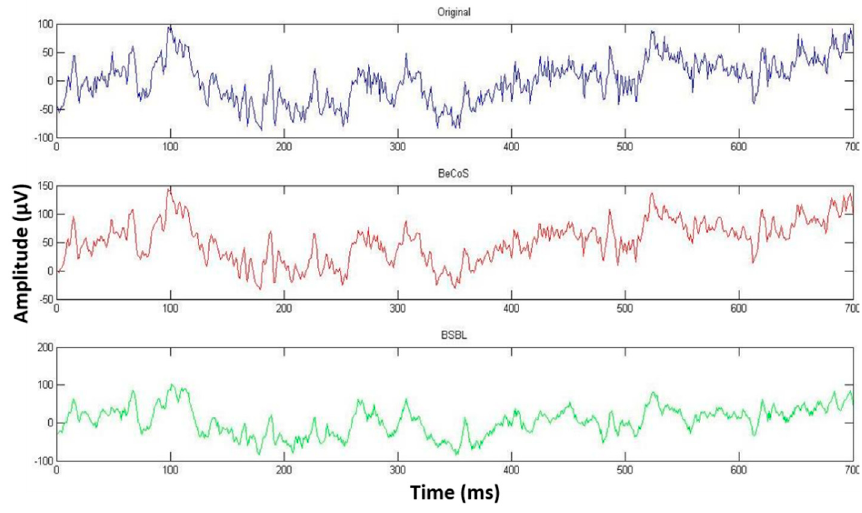
Figure 9. Complex-wavelet structural similarity (CW-SSIM) for Channel 7 [1:700].